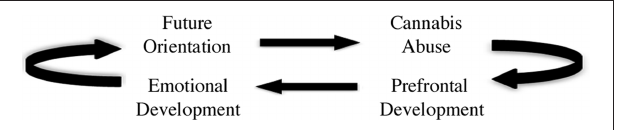
FiguRE 4 | Possible relationships among neural development, emotional development, substance abuse, and prospective thinking in decision making. Multiple entry points within the model (e.g., prefrontal development or cannabis abuse) suggest that a window of vulnerability may occur during normal neurodevelopment, emotional development and decision making, and may increase risk for cannabis abuse. Conversely, normal neurodevelopment may be altered by cannabis abuse, disrupt emotional development and decision-making capacities, and increase risk for compulsive drug